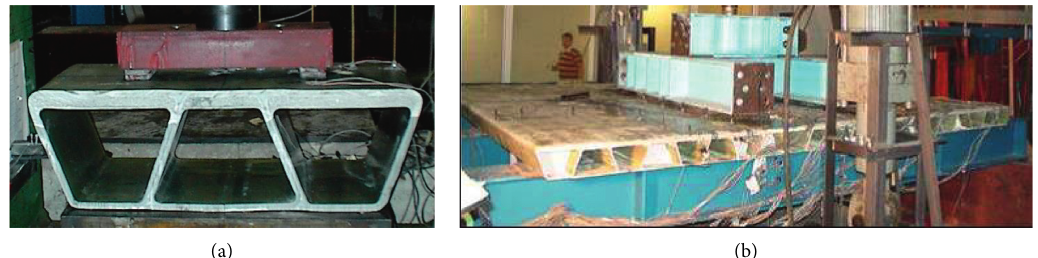
Figure 5: Hybrid deck system proposed by Alnahhal: (a) deck system; (b) deck on steel girders.